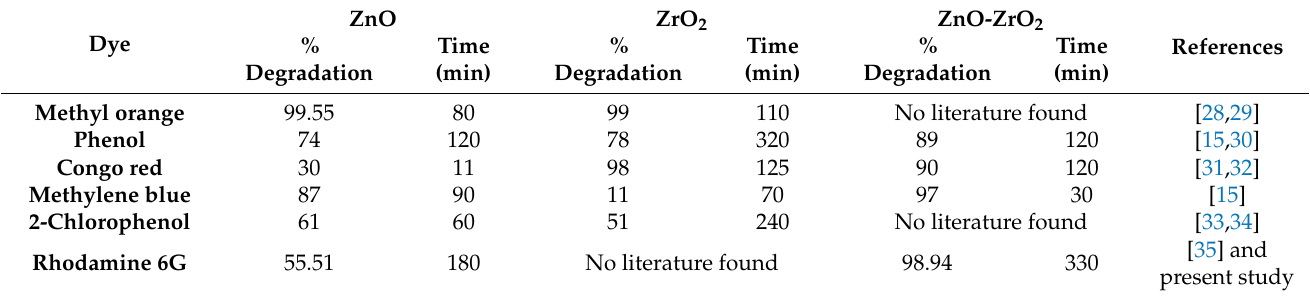
Table 1. Photocatalytic efficiency of ZnO, ZrO 2 and ZnO-ZrO 2 nanostructures against different organic pollutants.